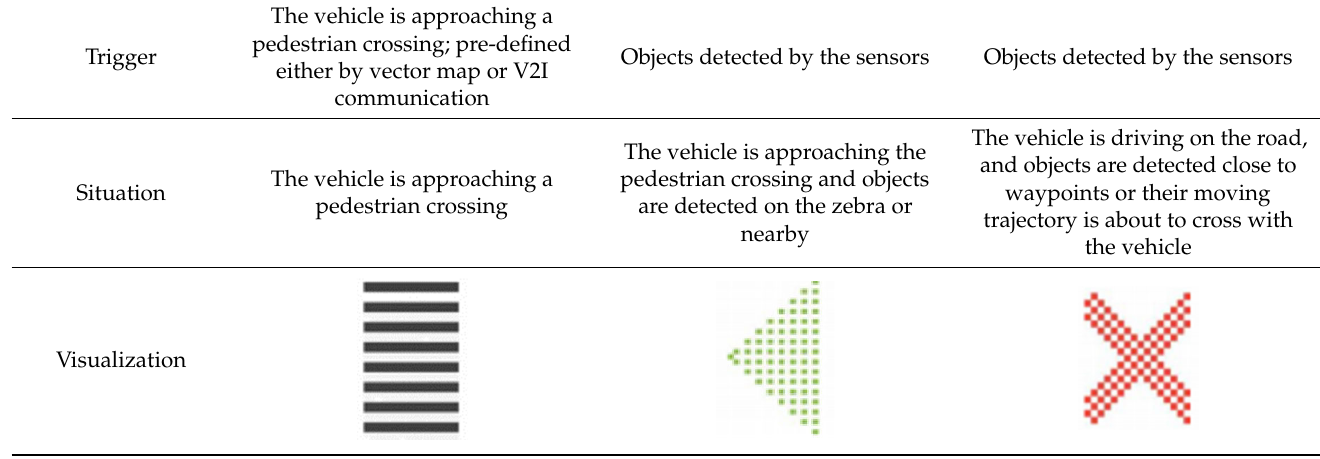
Table 1. LED signaling patterns used by the AV bus to communicate with other traffic participants.